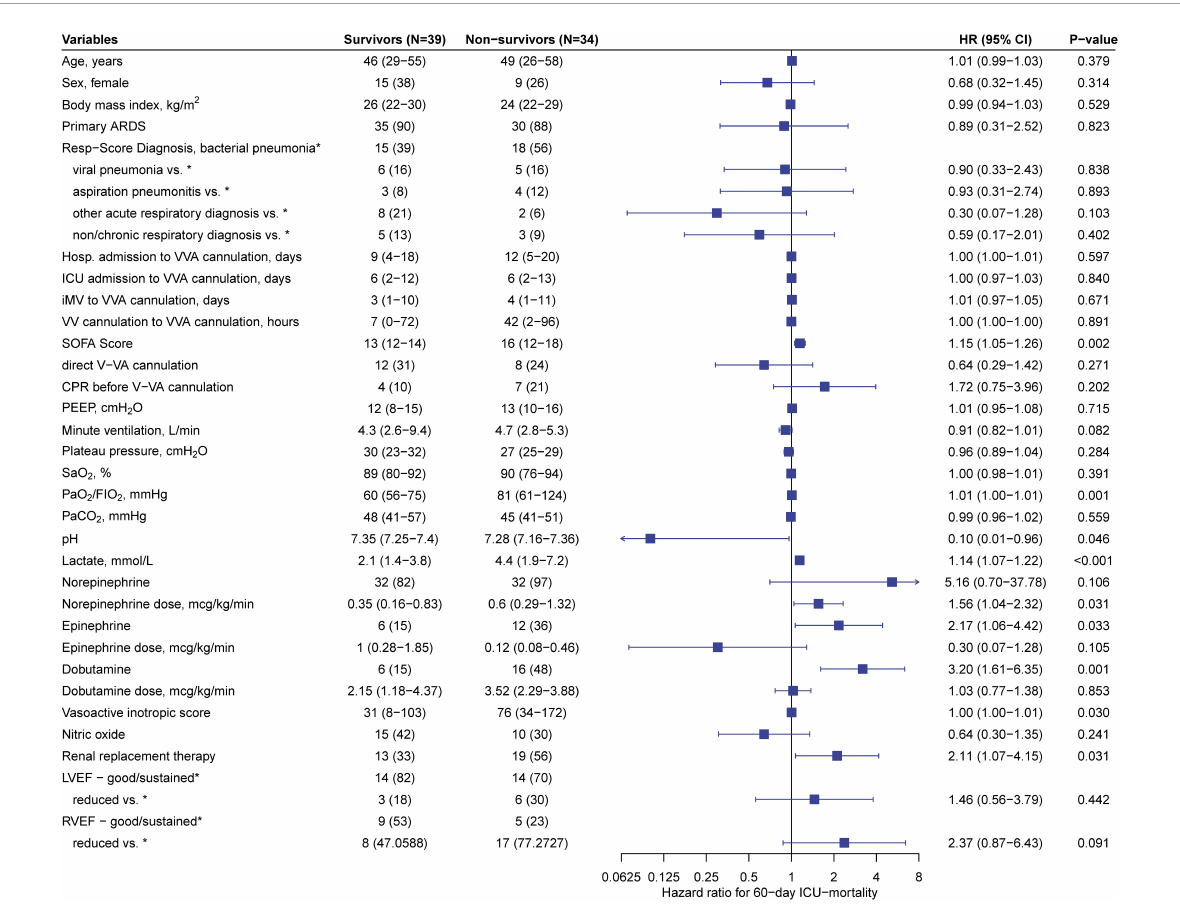
FIGURE2 Stratification of predictive variables at veno-veno-arterial ECMO cannulation. Left : Predictive variables at the time of V-VA ECMO cannulation stratified in survivors and non-survivors according to 60-day ICU mortality. Values are expressed as n (%) or median (interquartile range). Right : Forest-plot and univariate cox regression for 60-day ICU-mortality. Values are expressed as Hazard ratio (HR) with 95% confidence interval (CI) and p-value. ARDS, acute respiratory distress syndrome; CPR, cardiopulmonary resuscitation; FIO 2 , fraction of inspired oxygen; Hosp., Hospital; ICU, intensive care unit; iMV, invasive mechanical ventilation; LVEF, left ventricular ejection fraction; PaCO 2 , partial pressure of carbon dioxide; PaO 2 , partial pressure of oxygen.